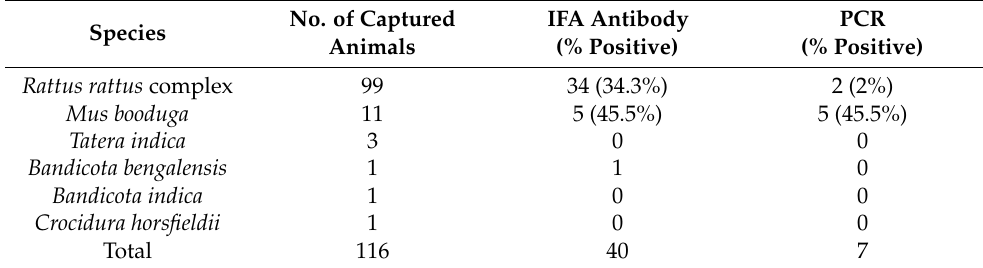
Table 1. Summary of the captured species and test